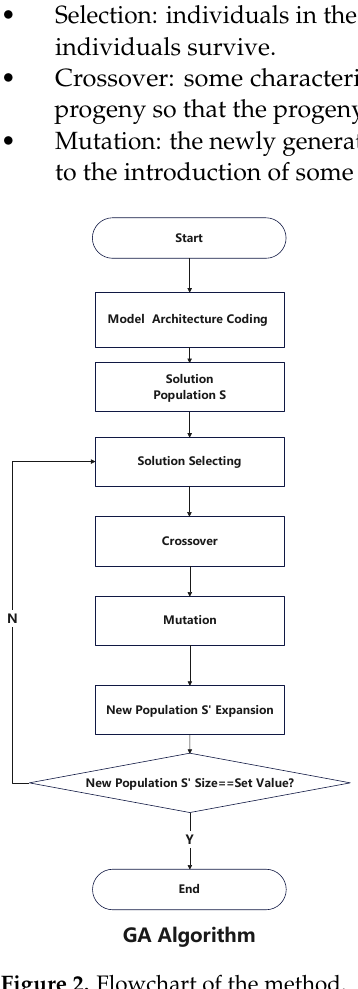
Figure 2. Flowchart of the